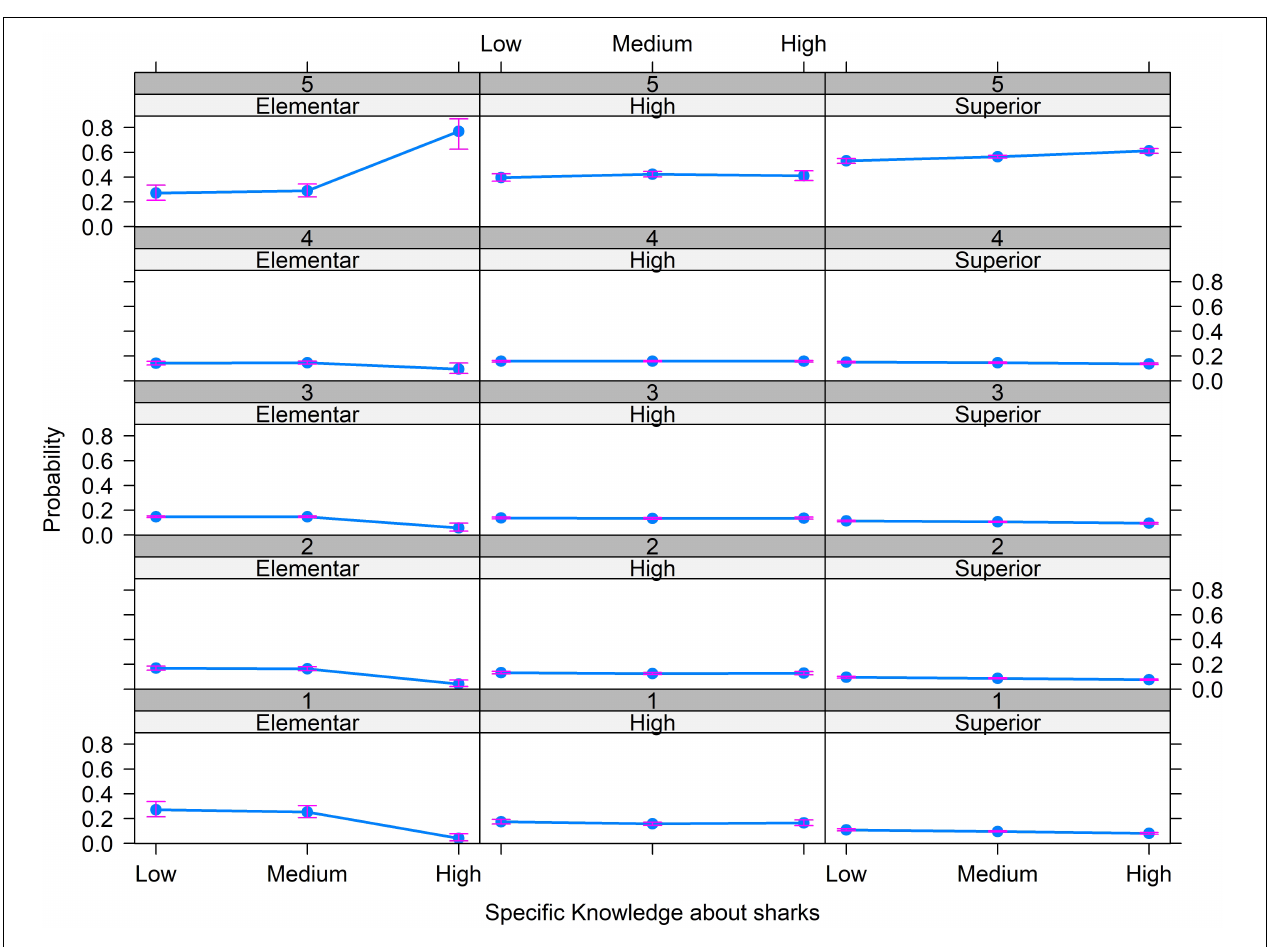
FIGURE 4 | Effects of the interaction of education level (i.e., elementary, high, and superior education) with specific knowledge about sharks (i.e., low, medium, and high) on the variability in perceptions toward sharks, assessed with a Likert-based ordered logistic regression model. The Likert scale spans from 1 through 5, with 5 being the most positive/correct option. The three panel columns correspond to education levels (elementary, high, and superior from the left through the right columns), whereas the five panel rows correspond to Likert options (ordered in descending order from the top through the bottom rows). Note that specific knowledge about sharks is a predictor variable derived with questions on specific quantitative metrics about sharks, whilst knowledge about sharks is a response variable derived with Likert questions about more general aspects of sharks. The complete model also included gender as a predictor